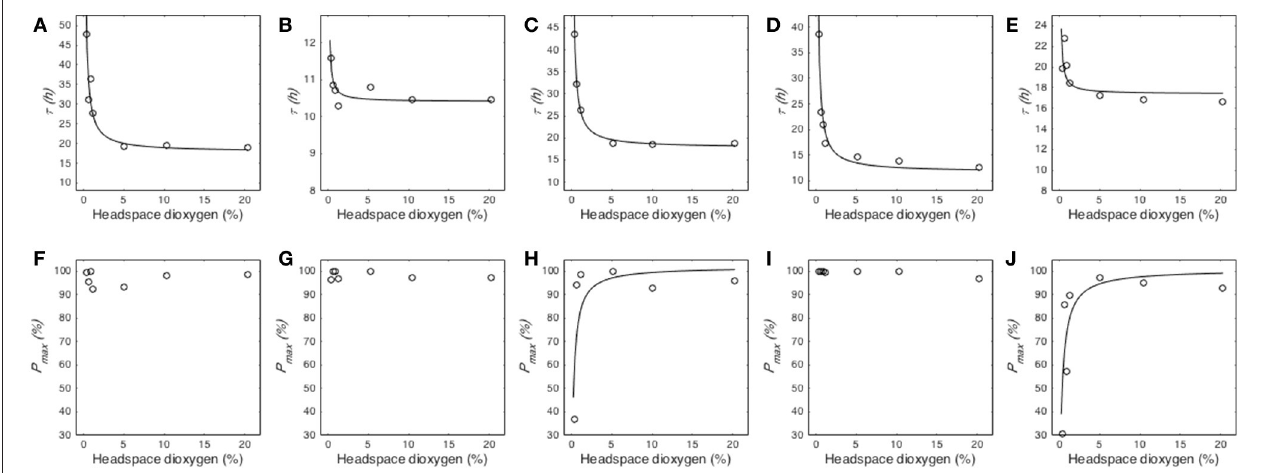
FIGURE 3 | Influence of O 2 partial pressure (%) in headspace on the median germination time τ (h) and maximum germination percentage P max (%) of Paecilomyces niveus UBOCC-A-11024 (A,F) , Mucor lanceolatus UBOCC-A-109153 (B,G) , Penicillium brevicompactum UBOCC-A-110007 (C,H) , Penicillium expansum